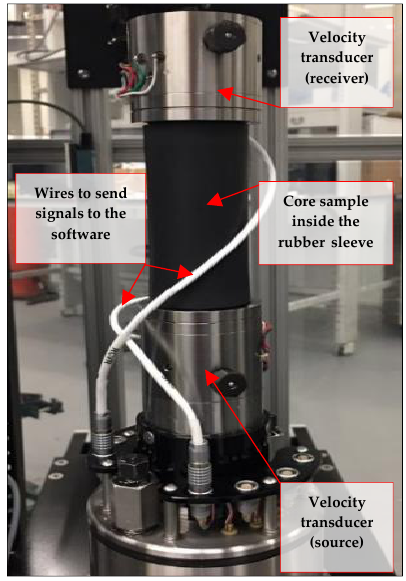
Figure 3. Core sample assembly is ready for axial velocity measurement.